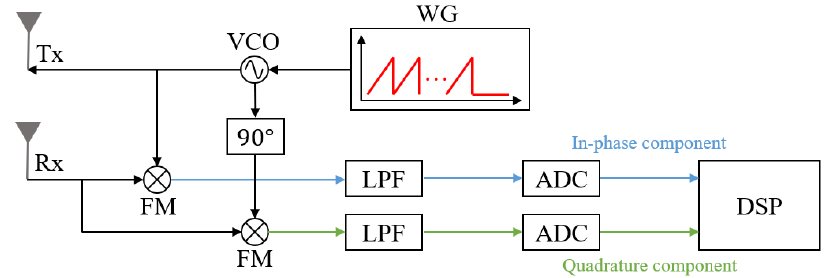
Figure 1. Block diagram of the FMCW radar